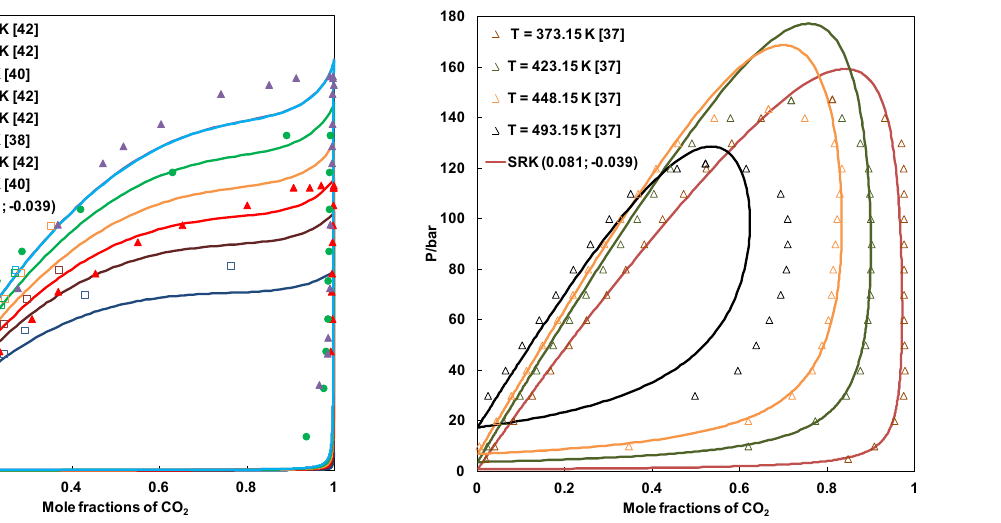
Figure 3. Comparison of literature data for the carbon dioxide + 2-methyl-1-propanol (isobutanol) system and calculations by SRK model: symbols, literature data at different temperatures; solid lines, predictions by SRK = 0.081, l = -0.039). ( k 12 12 Table 3. Critical data and acentric factor [56] for carbon dioxide and 2-methyl-1-propanol (isobutanol). Component